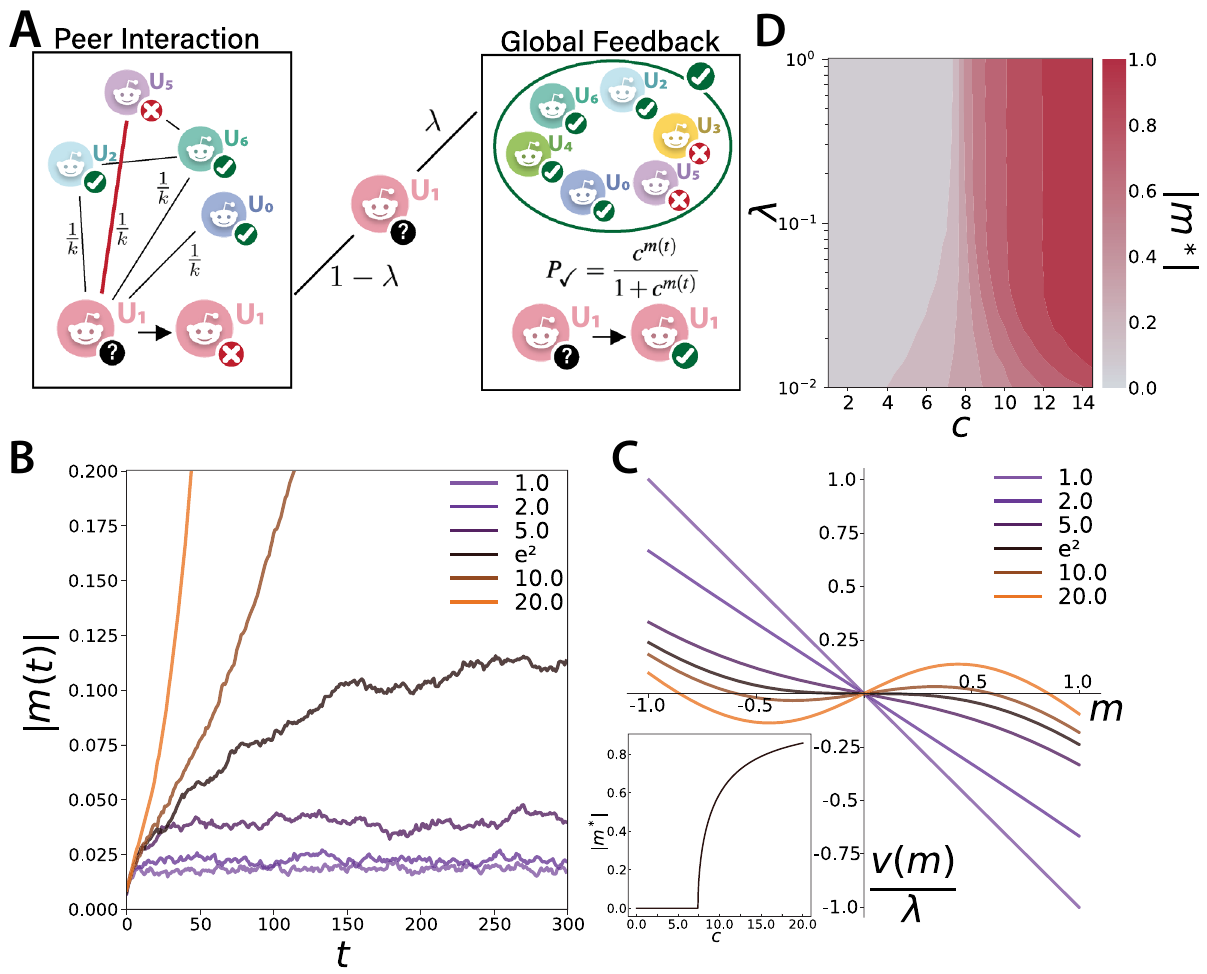
Figure 3. Voter model with self-induced global feedback. ( A ) Schematic representation of the update rule of the model. At each time step, a user takes on the opinion of either a randomly chosen neighbor (with probability 1 − (cid:31) ) or is influenced (according to a control parameter c ) by the current level of consensus in the community, namely the magnetization m . ( B ) Sample stochastic realizations of the model dynamics: temporal evolution of the magnetization m for different values of the parameter c setting the strength of the global feedback, for (cid:31) = 0.1 . ( C ) Re-scaled drift term v ( m ) of the model dynamics (according to the mean-field approximation, for (cid:31) = 0 ) as a function of the magnetization of the system. Inset: stable equilibrium points | m ∗ | as a function of c . ( D ) Phase diagram of the model simulated on Erdös-Rényi random graphs of N = 10000 nodes and average degree � k � = 20 . Icons in ( A ) have been designed by Freepik.